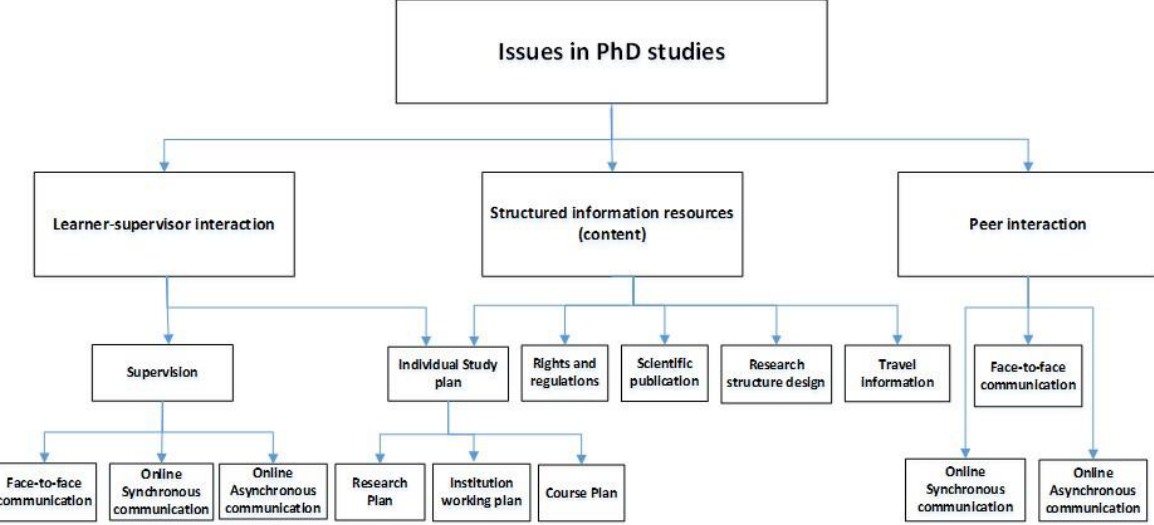
Figure 1 . Educational interaction in PhD studies that can be enhanced with the use of an ICTSS, to facilitate flexible and distance learning and collaboration